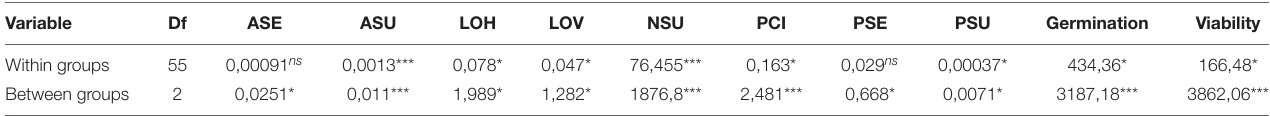
TABLE 1 | Sum of Squares from the Analyses of Variance (ANOVAs) for 10 seed characteristics evaluated on 56 genotypes of purple passion fruit ( Passiflora edulis f. edulis Sims) in three germplasm groups made up of 8 commercial cultivars, 14 genebank accessions and 34 landraces. Variable Df ASE ASU LOH LOV Within groups